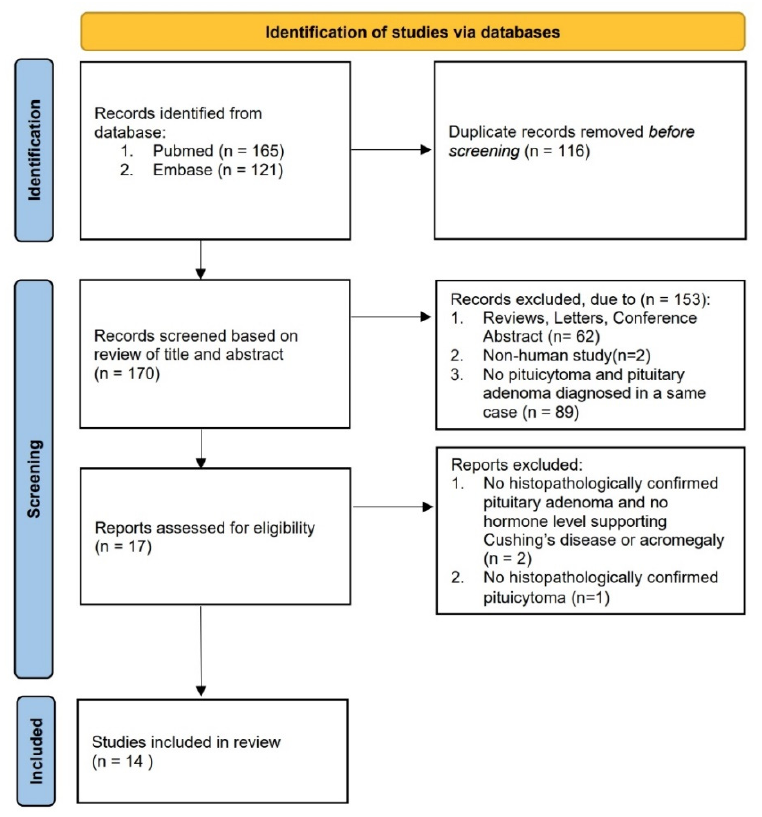
Figure 5. PRISMA flowchart showing the inclusion and exclusion criteria for the review. Overview: Pituicytoma Associated with Suspected Cushing’s